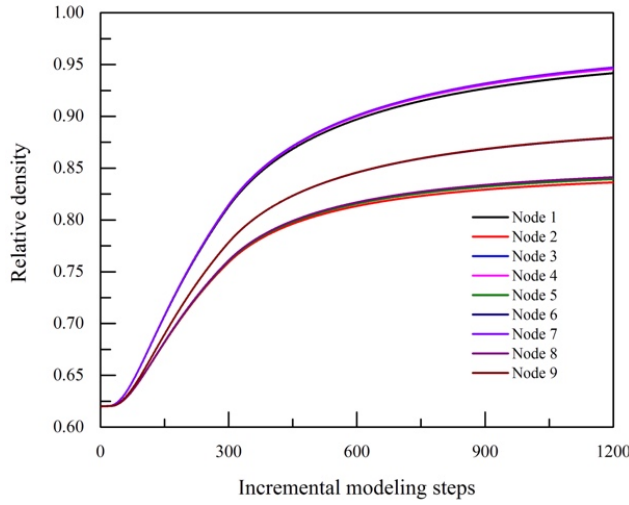
Figure 5. Variation of the relative density with incremental modeling steps for nine nodes.